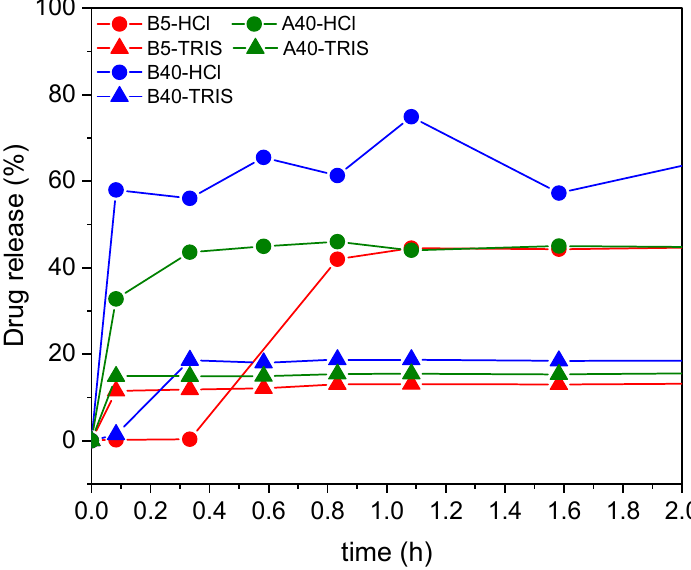
Figure 12. The percent of drug release in time for samples loaded in situ.